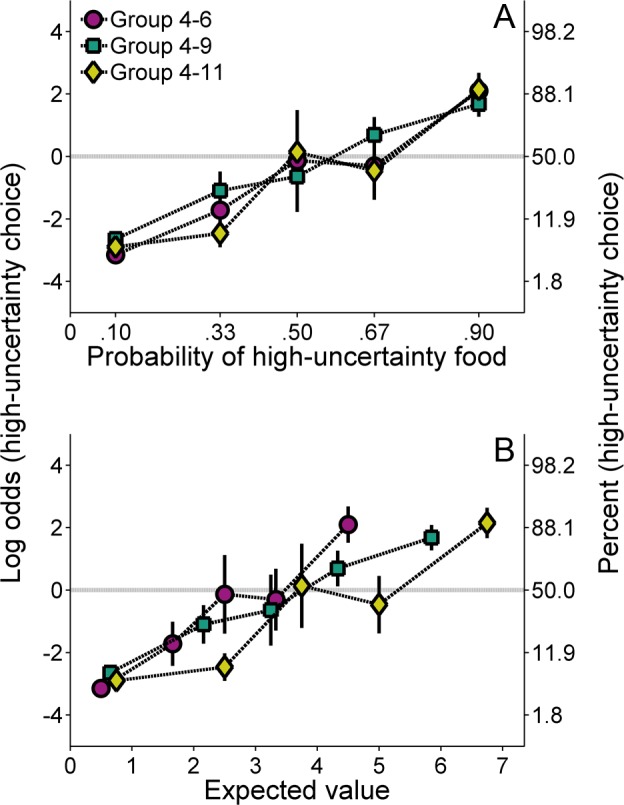
Mean (±SEM) log odds of high-uncertainty choices for each group in Experiment 2 as a function of the probability of high-uncertainty food delivery (A) and the expected value of a high-uncertainty outcome (B).A second ordinate showing percentages corresponding to the log odds values is included to aid interpretation.